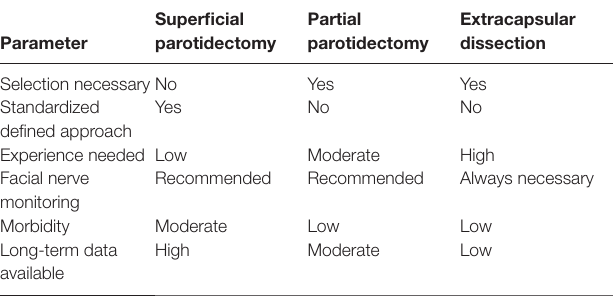
TABle 5 | Classification of parotid resection types by the European Salivary Gland Society (48).